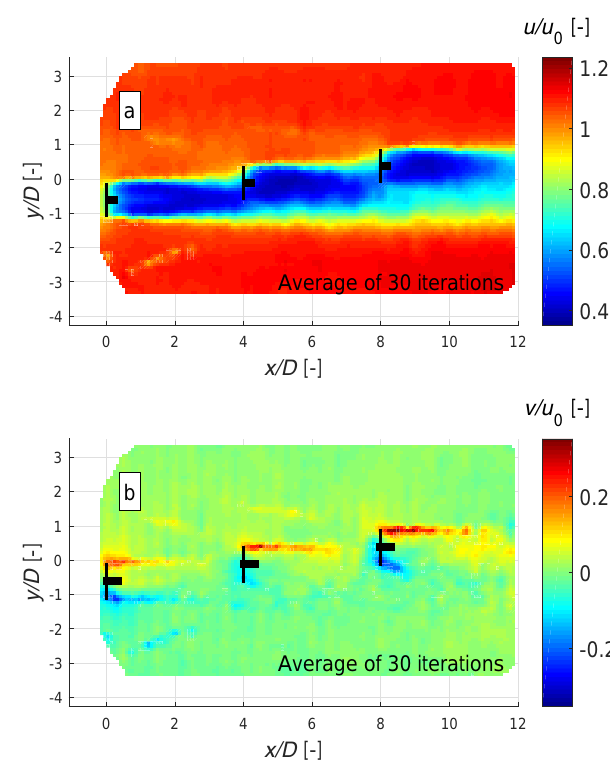
Figure 23. Wake wind field expressed in the line-of-sight compo- nent of R2D3 for (a) 1 iteration and an (b) average of 30 iterations.